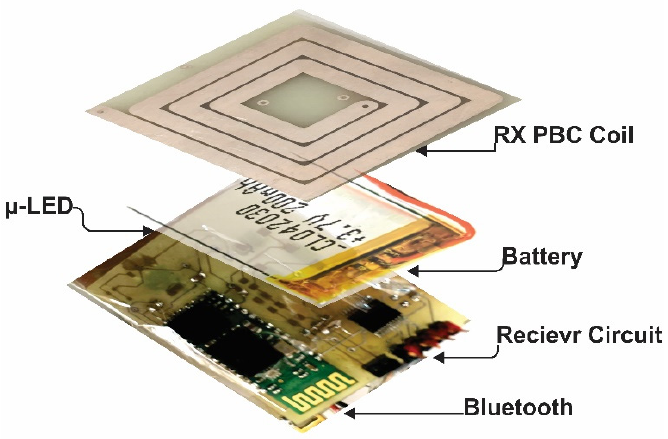
Figure 8. Receiver Module layers consist of RX PCB antenna, Li-ion Battery and rectifier and Bluetooth